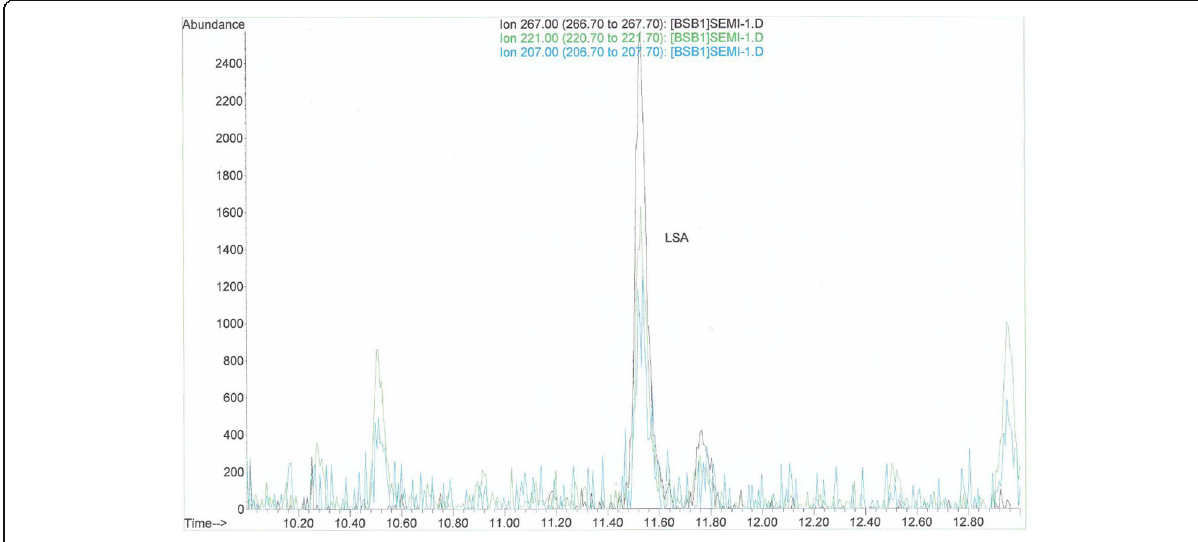
Fig. 4 Chromatograms of LSA from seed extracts